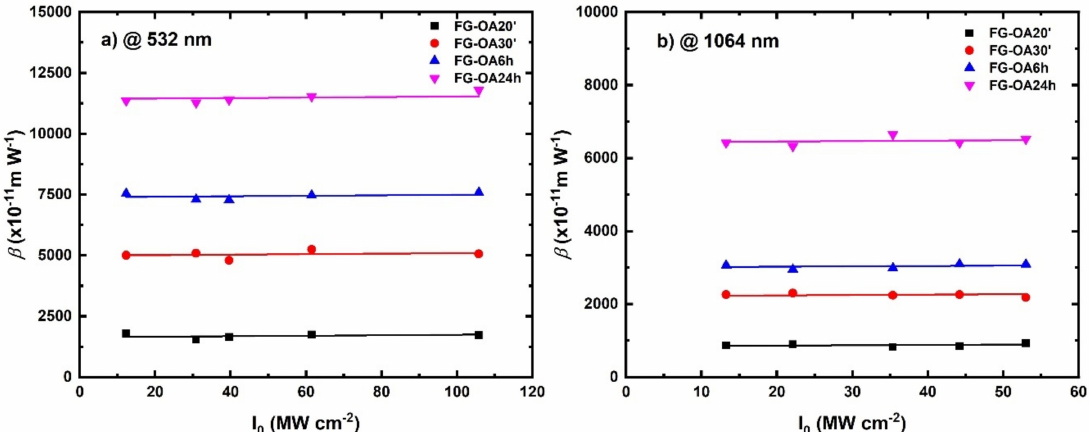
Figure 8. Dependence of the nonlinear absorption coe ffi cient β upon the on-axis peak intensity for ( a ) 532 nm and ( b ) 1064 nm laser